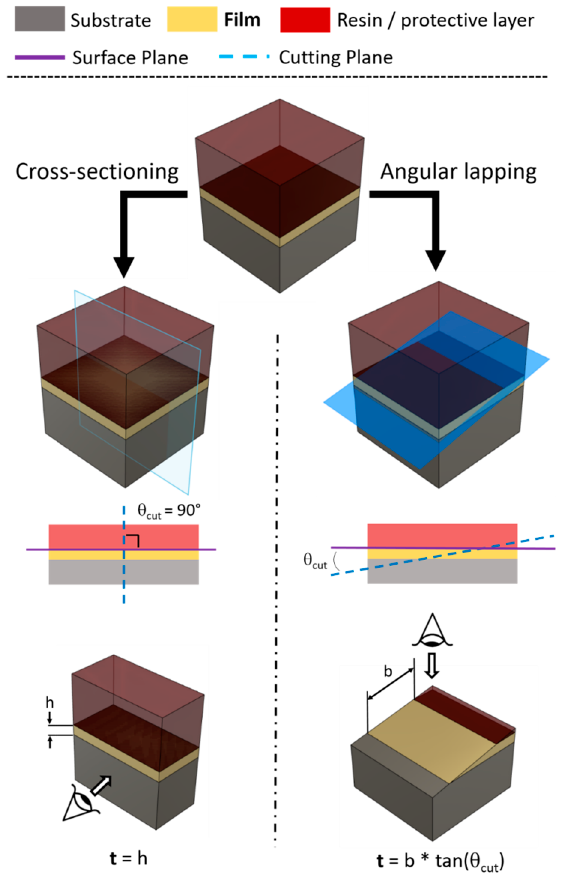
Figure 3. Comparison between film thickness determination: traditional cross-sectioning (using a cut perpendicular to the surface, ( left column )), and angle lapping (using small cutting angles in respect to the surface, ( right column )).